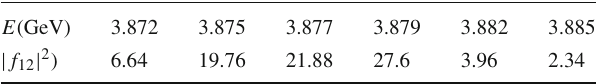
Table 2 The values of the transition probability as a function of energy in the transition 2)